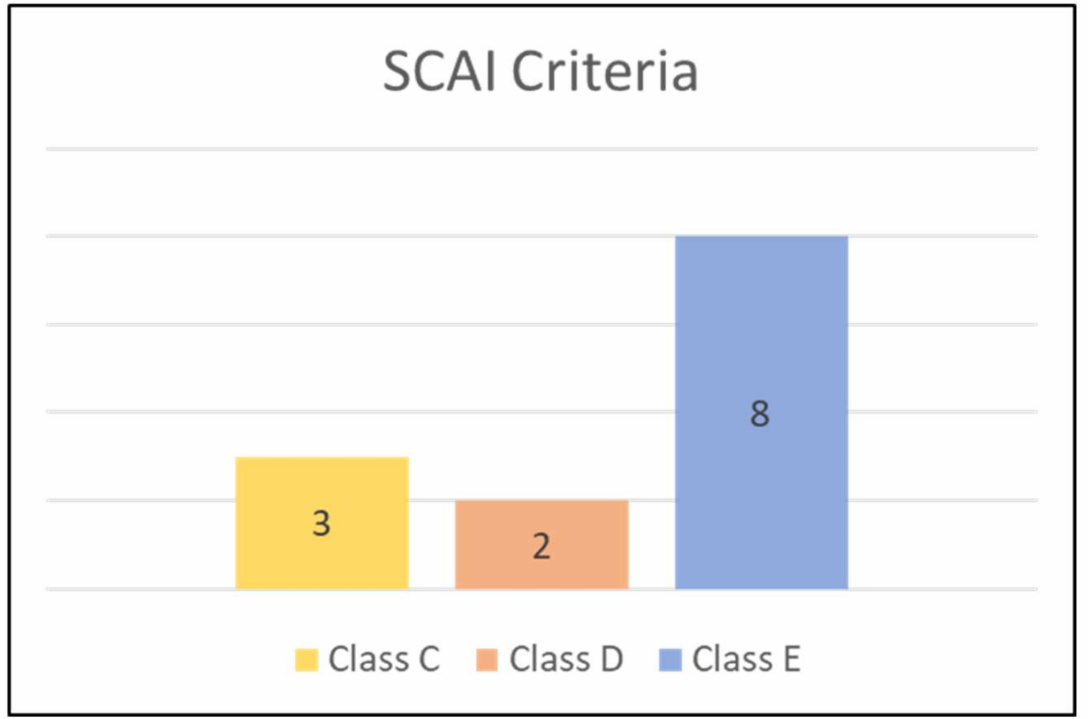
Figure 1. Patients’ severity, based on the Society for Cardiovascular Angiography and Interventions (SCAI) criteria, according to the SCAI classification of cardiogenic